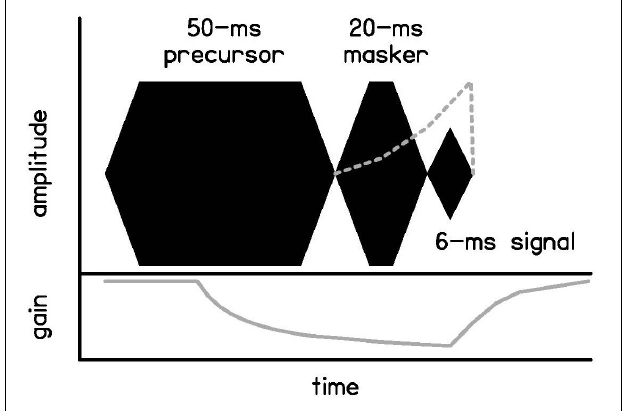
FIGURE 1 | Schematic of the temporal masking paradigm used in this experiment, including a 50-ms precursor, 20-ms masker, and 6-ms signal. The precursor or masker is removed in some experiments, but the temporal relationships are not changed. The frequency content of the precursors and maskers also vary across experiments, but the signal is always presented at 4 kHz. The gray dotted line shows a schematic of the timecourse of forward masking due to neural excitation. The gray solid line shows a schematic of the timecourse of forward masking due to cochlear gain reduction with a precursor